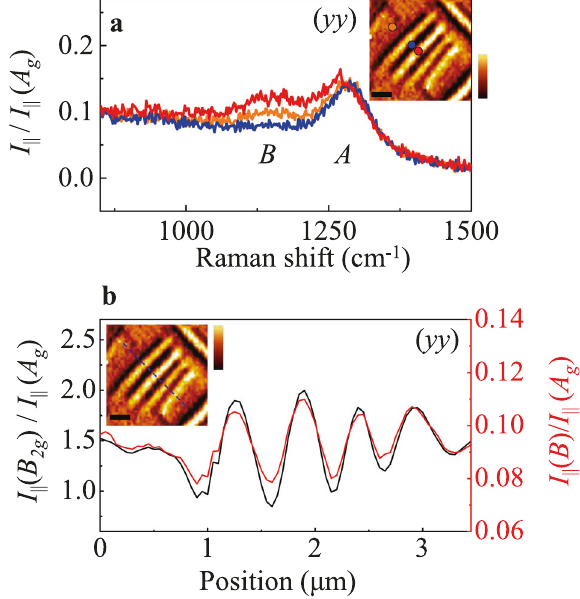
Fig. 5 Relation between the orientation of JT planes and orbiton- related peaks. a Raman spectra in a higher-energy regime (> 800 cm − 1 ) at three representative positions. The peaks of labels B and A have B 2g and A g symmetries, respectively. b Line pro fi les of the normalized Raman intensities of the fundamental B 2g mode (black) and the B peak of the orbiton (red). The dashed line in the inset indicates the corresponding positions. All data were obtained in the ( yy ) polarization con fi guration. (Insets) An identical Raman map for the normalized intensity of B 2 g mode. The color scales vary from 0.8 to 1.5. The spatial scale bars stand for 1 μ